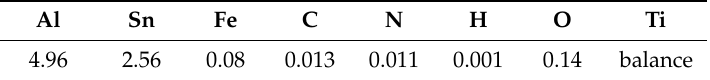
Figure 1. The microstructure of the annealed Ti–5Al–2.5Sn rod. Table 1. The chemical composition of the as-received